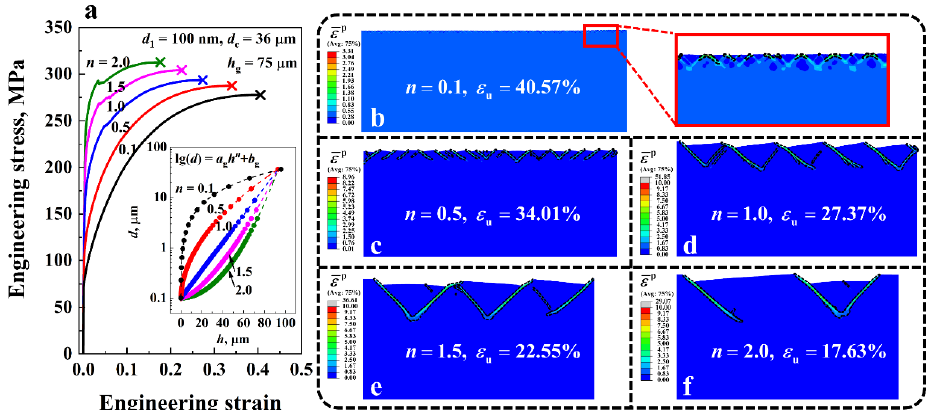
Figure 8. ( a ) Engineering stress-strain curves of the gradient Cu with different grain size distribution index n ranging from 0.1 to 2. Variations of the grain size d along the thickness direction of the material under different n are shown in the inset. ( b – f ) Comparison of the shear band patterns of the gradient Cu with different n at the uniform elongation ε u . Regions with equivalent plastic strain ε p larger than 1 are enclosed by black dashed lines.